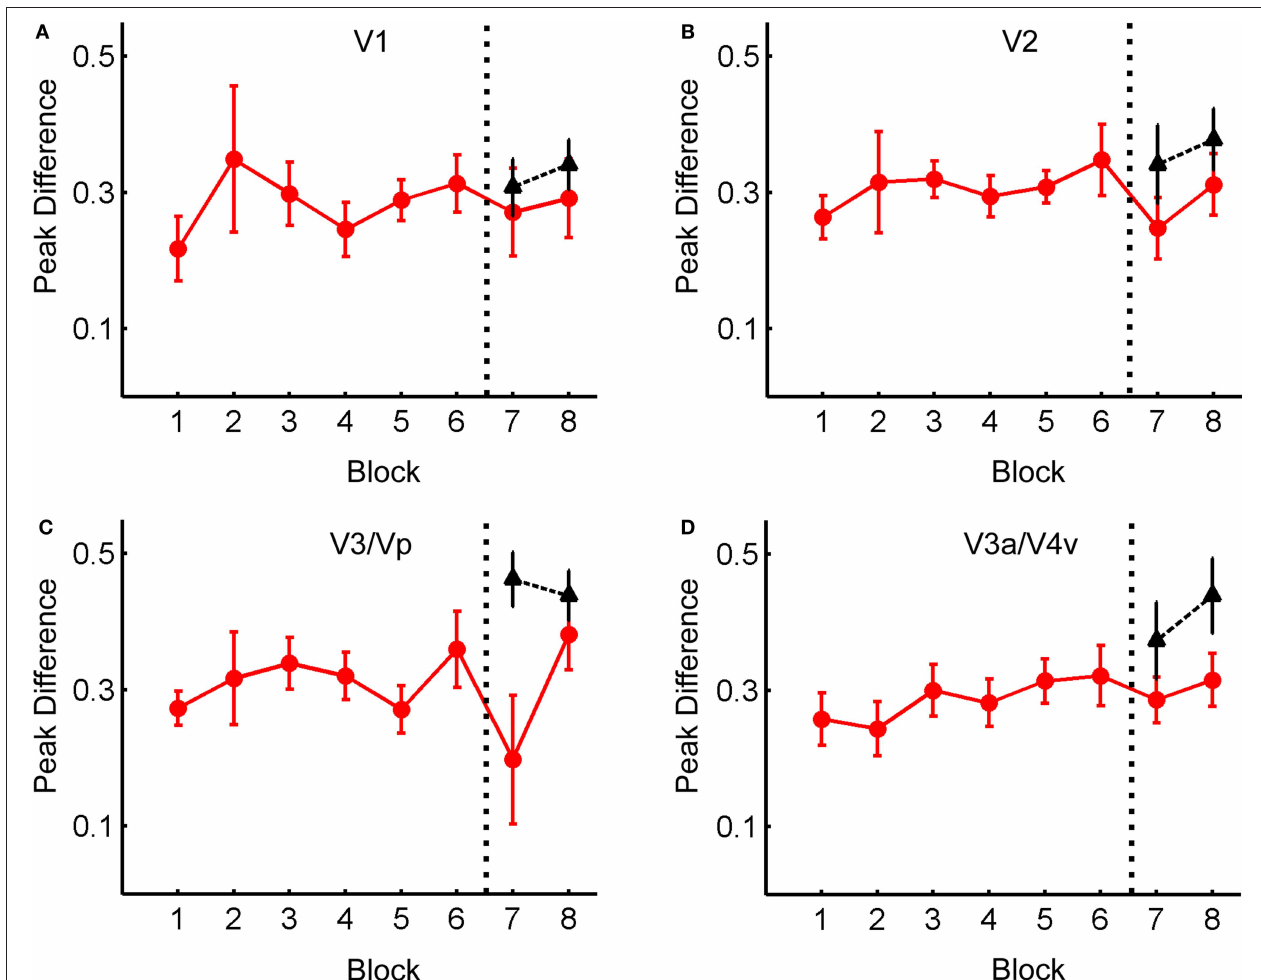
The data presented are taken from those areas of cortex responding maximally to a stimulus appearing in the in a given location (e.g., Upper-Left distractor responses are taken from areas that respond most to a stimulus appearing in the upper-left distractor location, etc), then averaged across locations. Positive value indicates a greater BOLD response when a distractor was present.